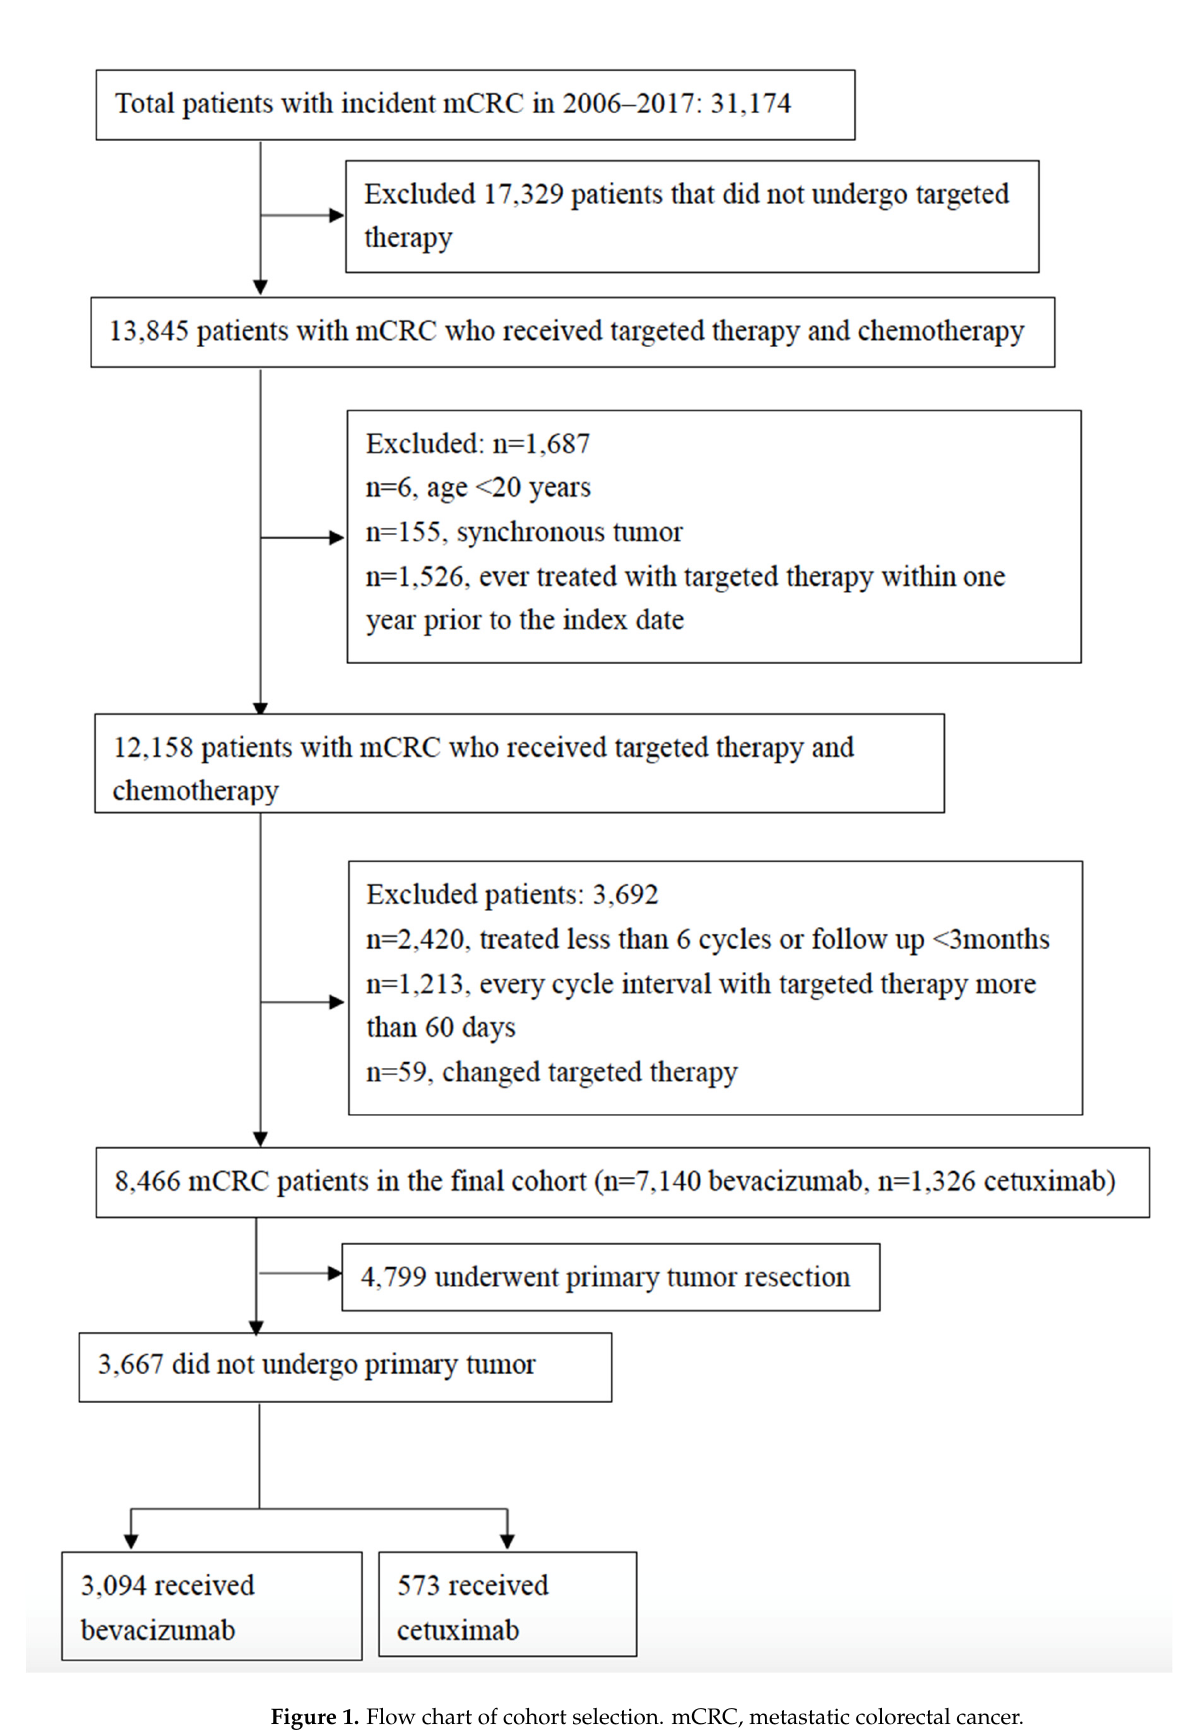
Figure 1. Flow chart of cohort selection. mCRC, metastatic colorectal cancer.